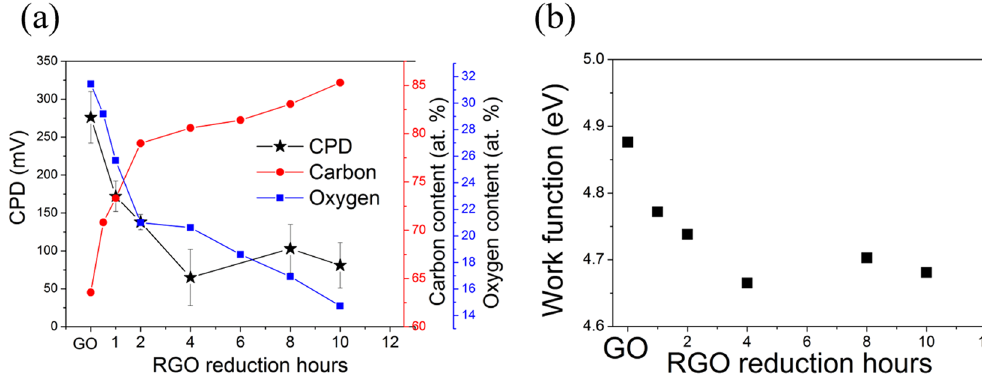
Figure 7. ( a ) The changes in CPD, carbon and oxygen content of rGO samples with its associated time dependence. ( b ) The work function of rGO samples as a function of reduction